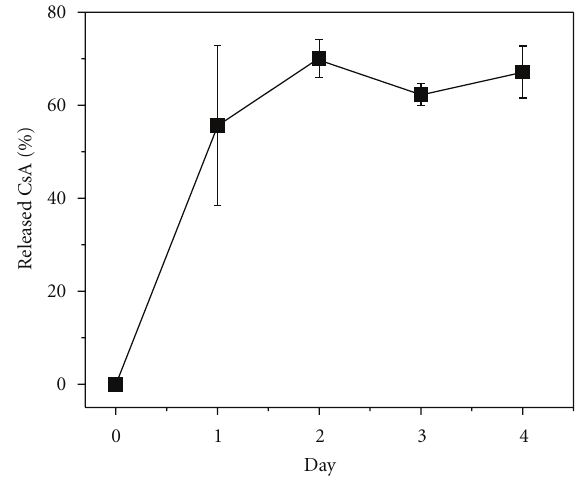
Figure 3: The release profile of CsA from CsA/PEG-PLGA-NPs in PBS (1 × ) at 37 ◦